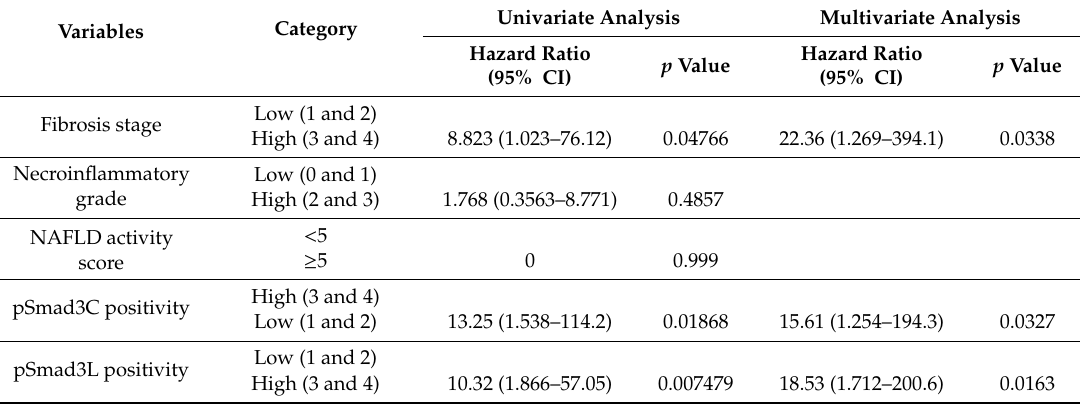
Table 3. Phospho-Smad3L / C and fibrosis stage are independent predictors of HCC